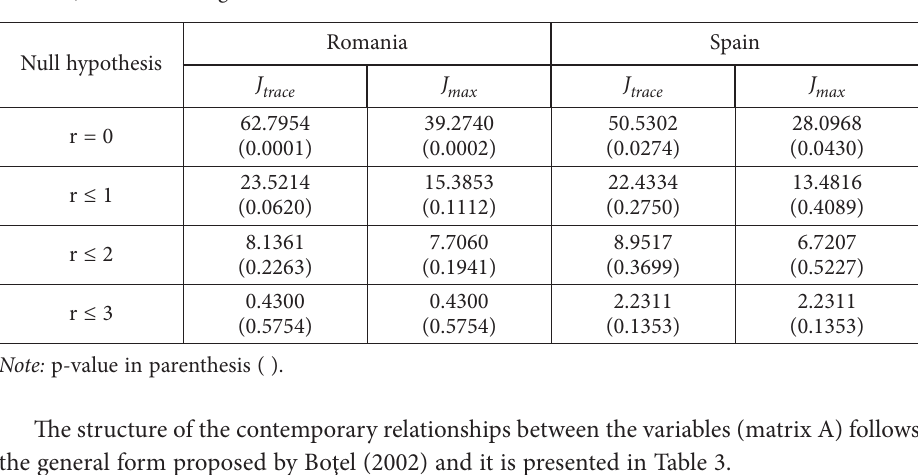
Table 2. Johansen cointegration test